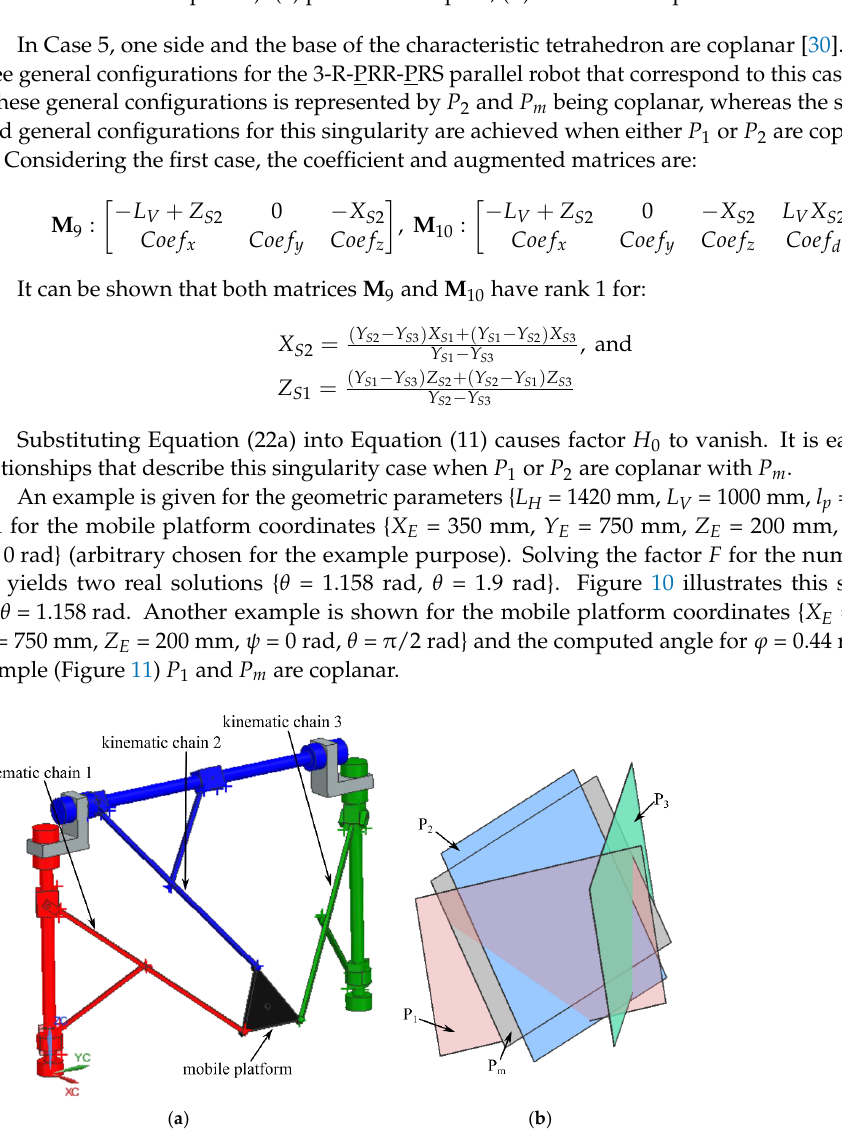
the characteristic tetrahedron are coplanar): ( a ) parallel robot pose; ( b ) P 2 and P m are